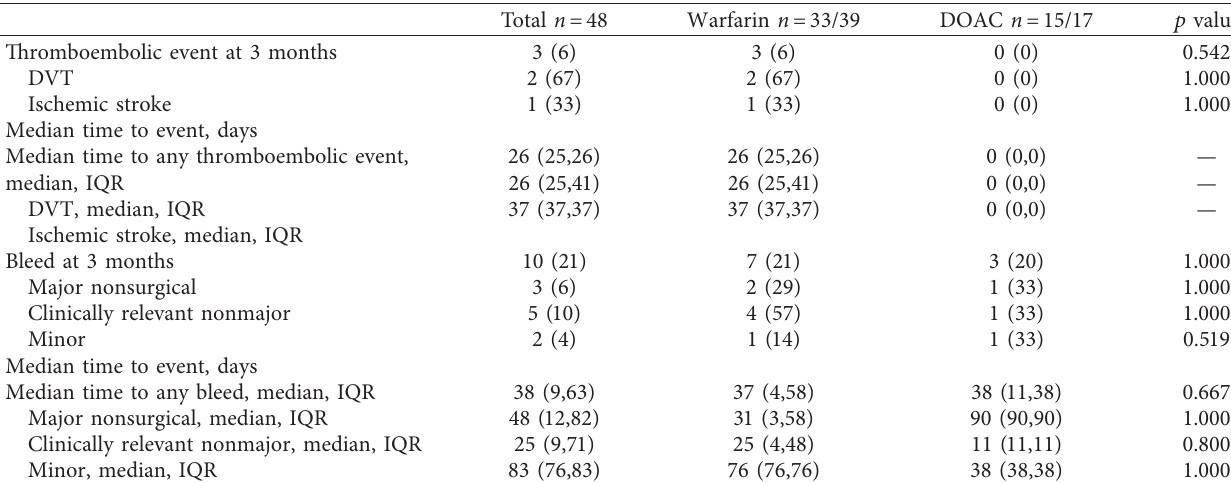
Figure 2: Bar graph of number of patients who had a bleed event, thromboembolic event, and/or discontinued anticoagulation therapy n � 14/48 (29%). Table 2: Secondary